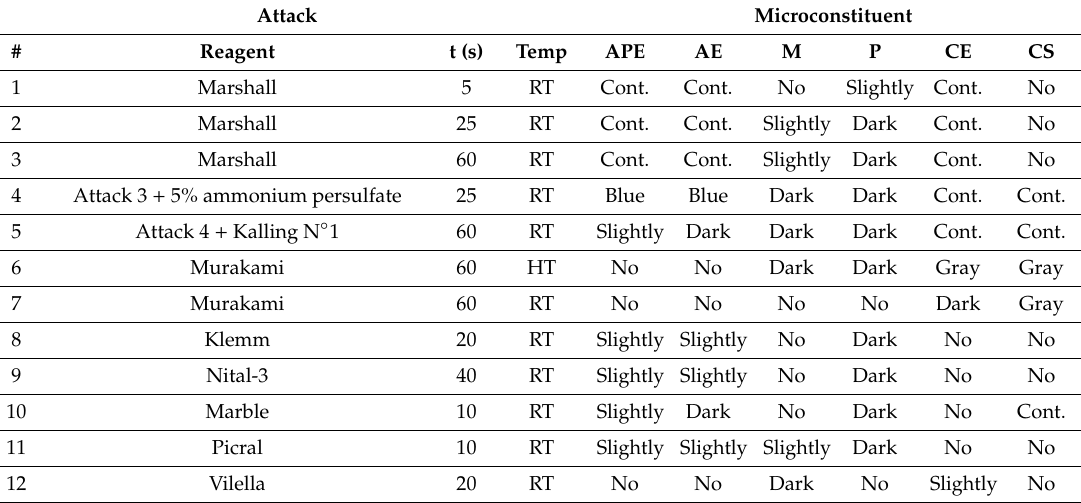
Table 2. Microconstituents status after each attack studied (APE: Proeutectic austenite; AE: Eutectic austenite; M: martensite; P: pearlite; CE: eutectic carbides; CS: secondary carbides; RT: room temperature; HT: high temperature; Cont.: contoured).